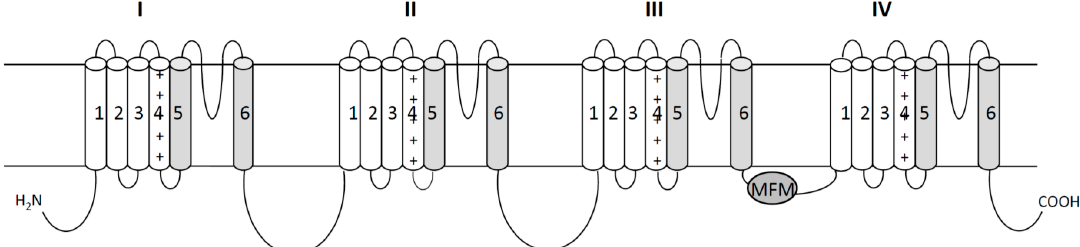
Figure 1. The topology of the mosquito sodium channel indicating the structural features that are critical for sodium channel function. The sodium channel protein contains four homologous repeat domains (I–IV), each having six α -helical transmembrane segments (S1–S6). In each domain, the S1–S4 segments constitute the voltage-sensing module. “+” represent positively charged amino acid residue in S4 segment. The segments S5, S6, and membrane-reentrant P-loops that connect the S5 and S6 segments form the pore module (fill in gray). The amino acids D, E, K, and A (the selectivity-filter motif “DEKA”) in the analogous positions of domains I, II, III, and IV, respectively, determine the ion selectivity of sodium channels. The isoleucine in the IFM (amino acid residues I, F and M) motif that is critical for fast inactivation in mammalian sodium channels is substituted with a methionine in insect sodium channels.